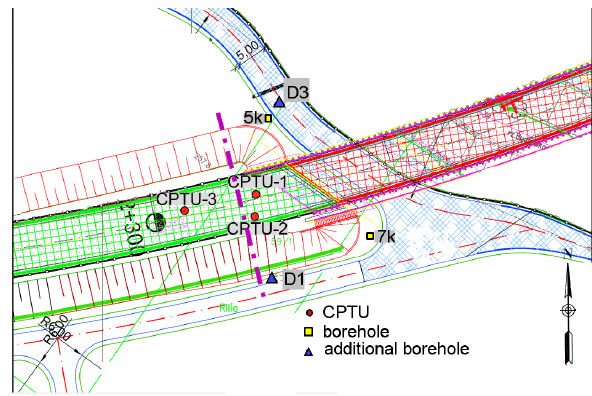
Figure 2: Location of test points and the calculation cross-section.